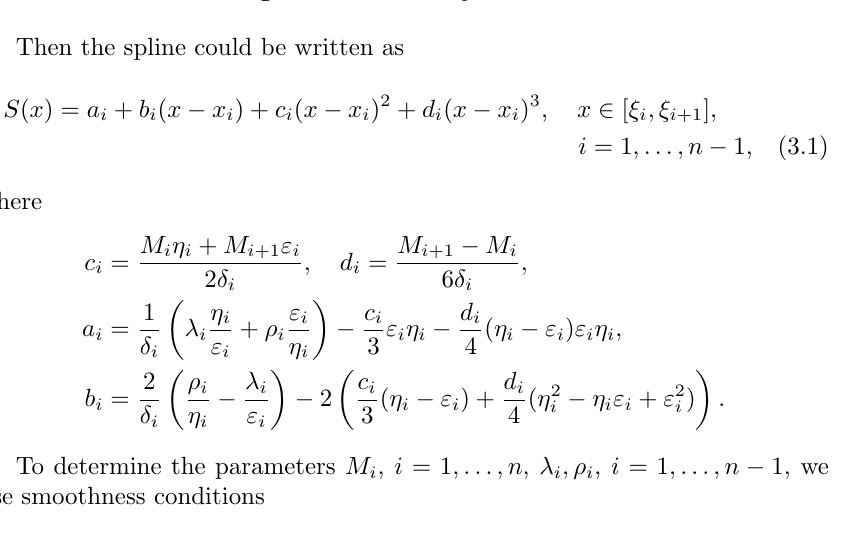
Figure 1. Additional